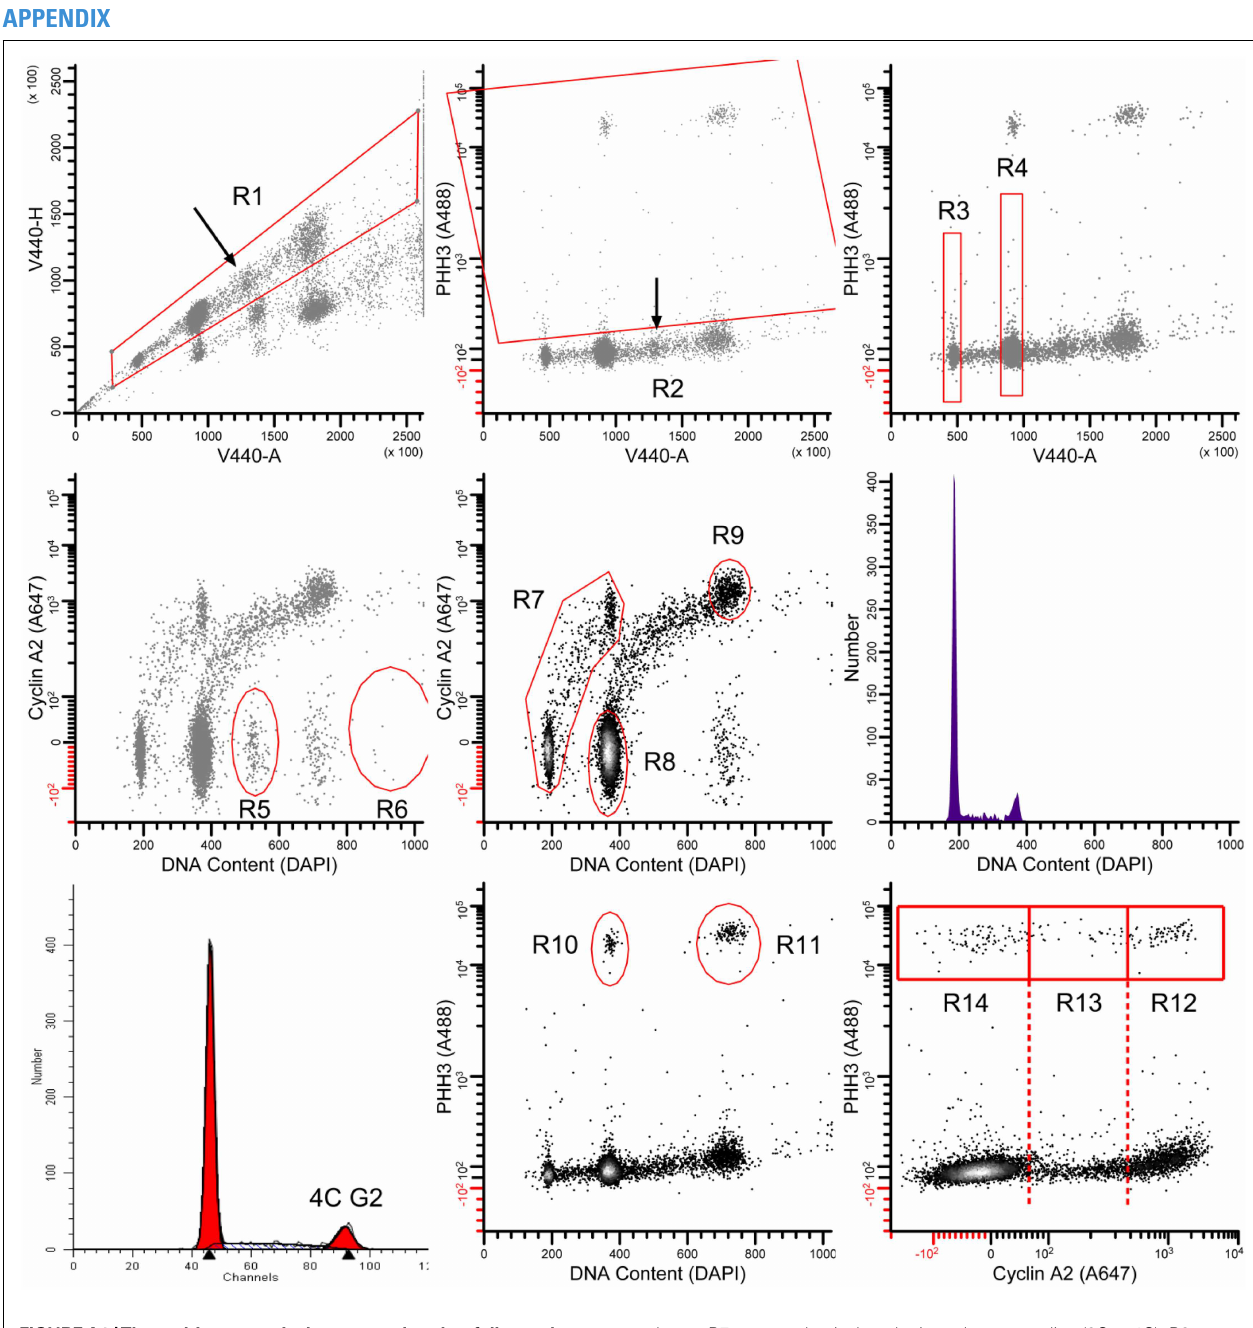
FIGUREA1 |The multi-parametric data are analyzed as follows: the region R1 gates in singlet cells and excludes all else; the region R2 classifies all mitotic cells .The regions R3 and R4 were used to determine the median value of integrated DAPI fluorescence signal from the violet laser (V440-A).These values were used to transform DAPI fluorescence measurements of G1 and G2/M cells to mean values of 180 and 360, respectively [labeled DNA Content (DAPI)]. R5 and R6 were used in some samples to remove additional doubles that were missed by the doublet discriminator (arrow in upper left panel).These are recognizable by ∼ 6C content, G1 levels of cyclin A2 signal, and a distinct